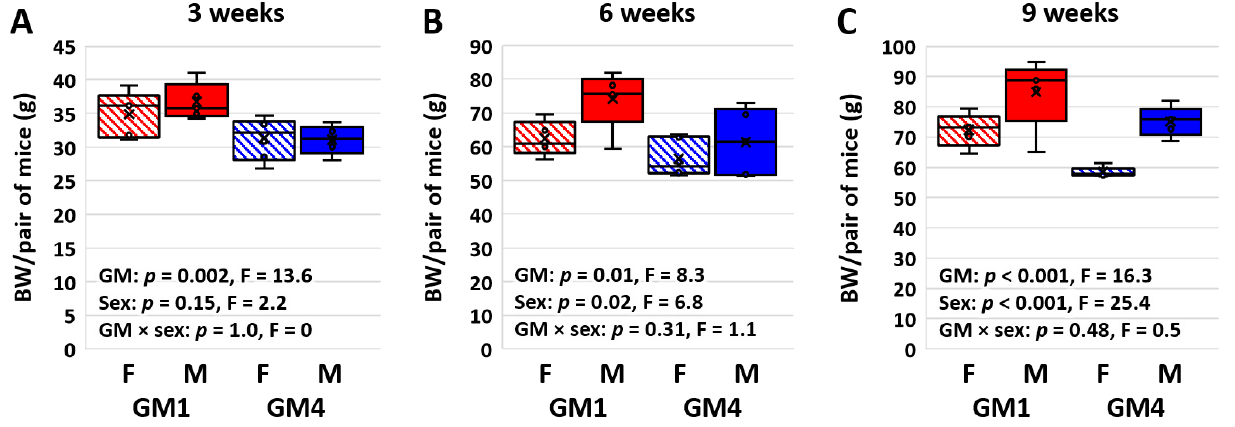
Figure 1. Box plots showing the collective body weight (BW) of pairs of female (F) or male (M) mice colonized with GM1 or GM4 at three ( A ), six ( B ), and nine ( C ) weeks of age ( n = 5–6 cages/sex/GM). Statistical analysis performed using two-way ANOVA within each time point.